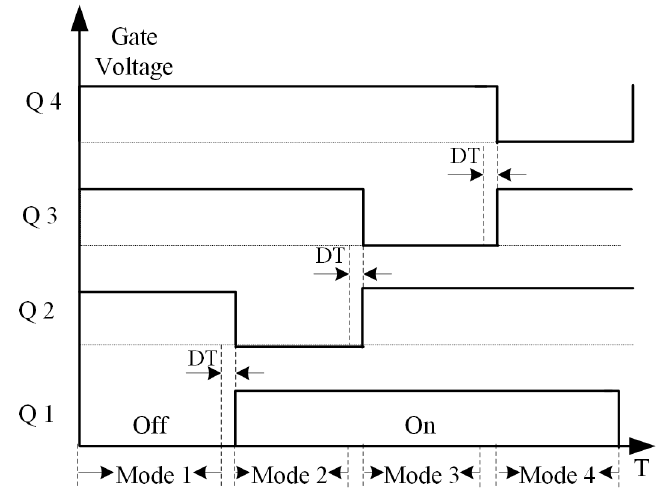
Figure 1. Multi-switched inductor balancing circuit (MSIBC)-based balancing system with a fuzzy logic (FL) controller.